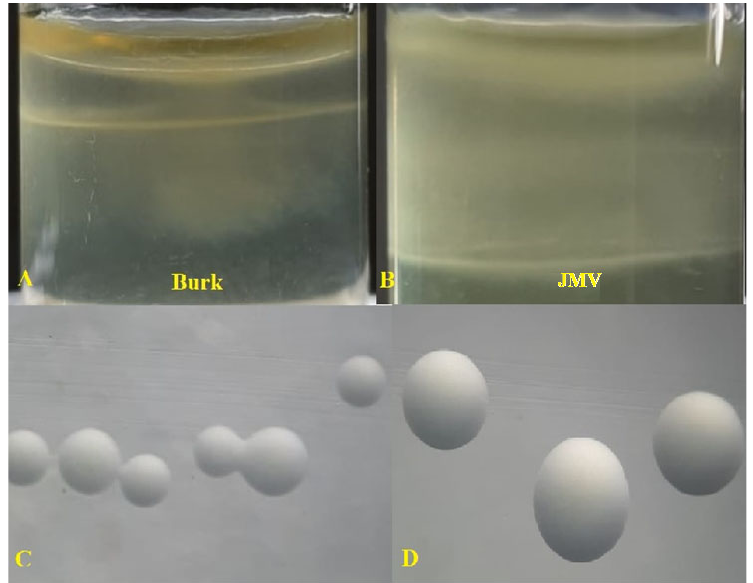
Figure 5. Phenotypic characteristics in semi-solid medium ( A , B ) and morphocolonial characteristics in solid medium ( C , D ) of the Burkholderia vietnamiensis TUR 04-03 strain grown in two nitrogen-free culture